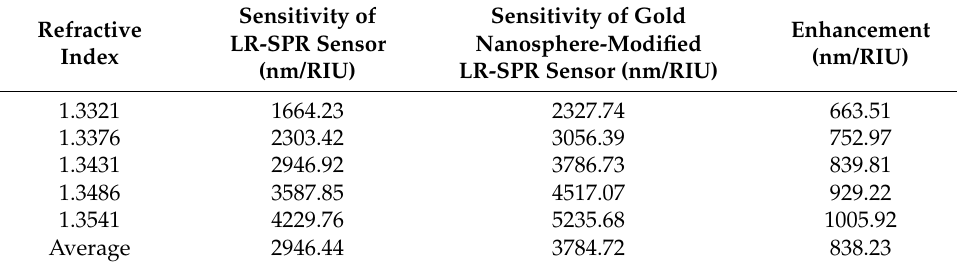
Table 1. The sensitivity of the two types of LRSPR sensor.